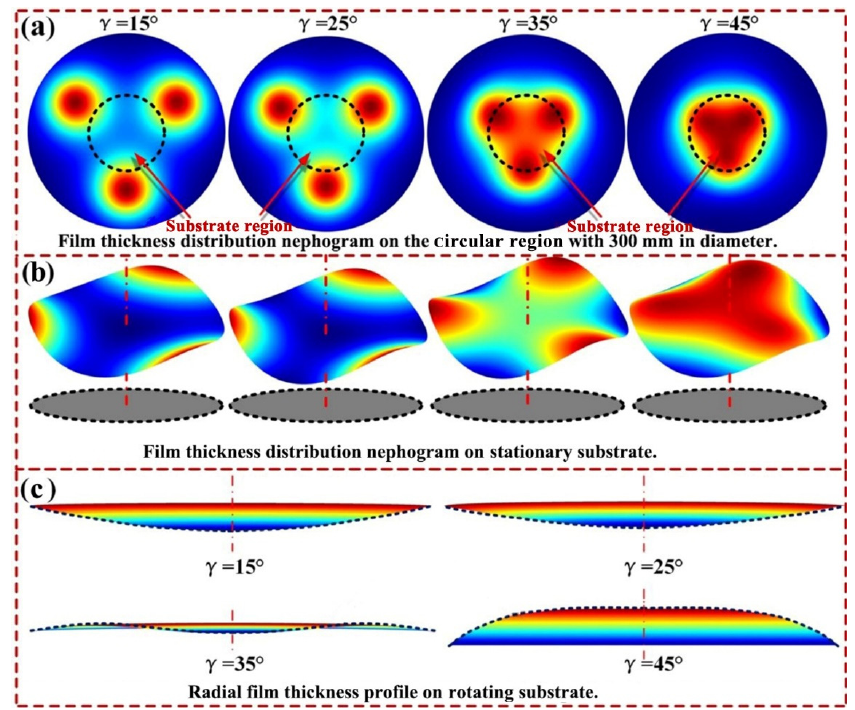
Figure 6. Evolution mechanisms of the deposition uniformity of triple-target magnetron co-sputter- ing system with target-substrate angle. ( a ) Film thickness distribution nephograms on the circular region with a diameter of 300 mm; ( b ) 3D nephograms of the film thickness distribution on the stationary substrate; ( c ) Section profiles of the film thickness distribution on the rotating